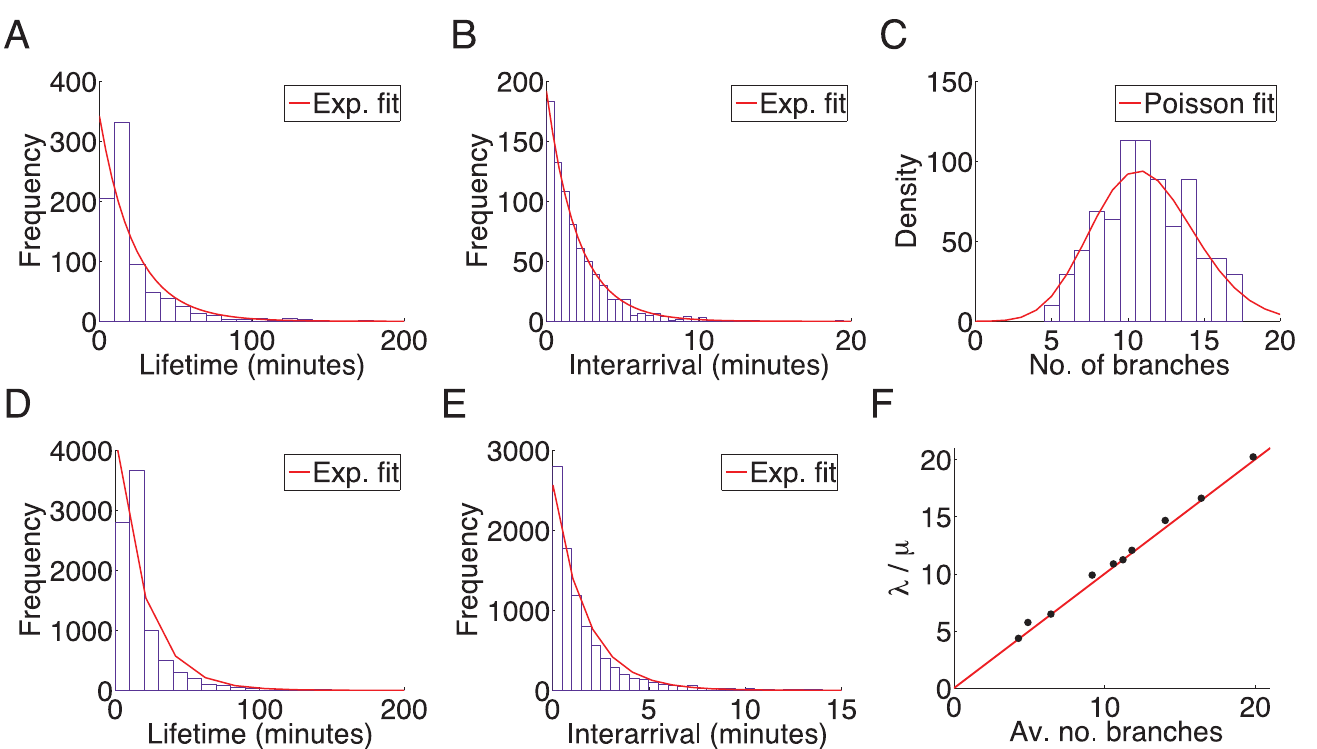
Fig 3. The lifetime and interarrival statistics from control axons fit an exponential distribution, and the number of branches on an axon is well represented by a stochastic birth-death process. (A): The histogram of the lifetime of the branches and the fitted exponential distribution with death rate ( ^ m ¼ 0 : 044 (with a 90% CI of 0.041, 0.047)) from one axon with 787 branches. (B): The histogram of the interarrival time between branches and the fi tted exponential distribution with birth rate ( ^ l ¼ 0 : 49 (0.46,0.52)) from the same axon. (C): The distribution of the number of branches in each frame (10 minutes apart) for one axon. The red line shows the fi tted Poisson distribution with parameter 11.22 (10.70,11.74). (D): The lifetime distribution of branches from 10 control axons with 8876 total branches. The fi tted exponential parameter for the death rate was ^ m ¼ 0 : 048 (0.047, 0.049). (E) The interarrival time distribution of branches from the 10 control axons. The fi tted exponential parameter for the interarrival time was ^ l ¼ 0 : 5883 (0.5761, 1.503). (F): The ratio of the lifetime and interarrival parameter estimates against the average number of branches for 10 axons. The red line shows ^ l = ^ m equal to the average number of branches, demonstrating that the average number of branches the axon has depends on the unique birth and death rates of its branches.